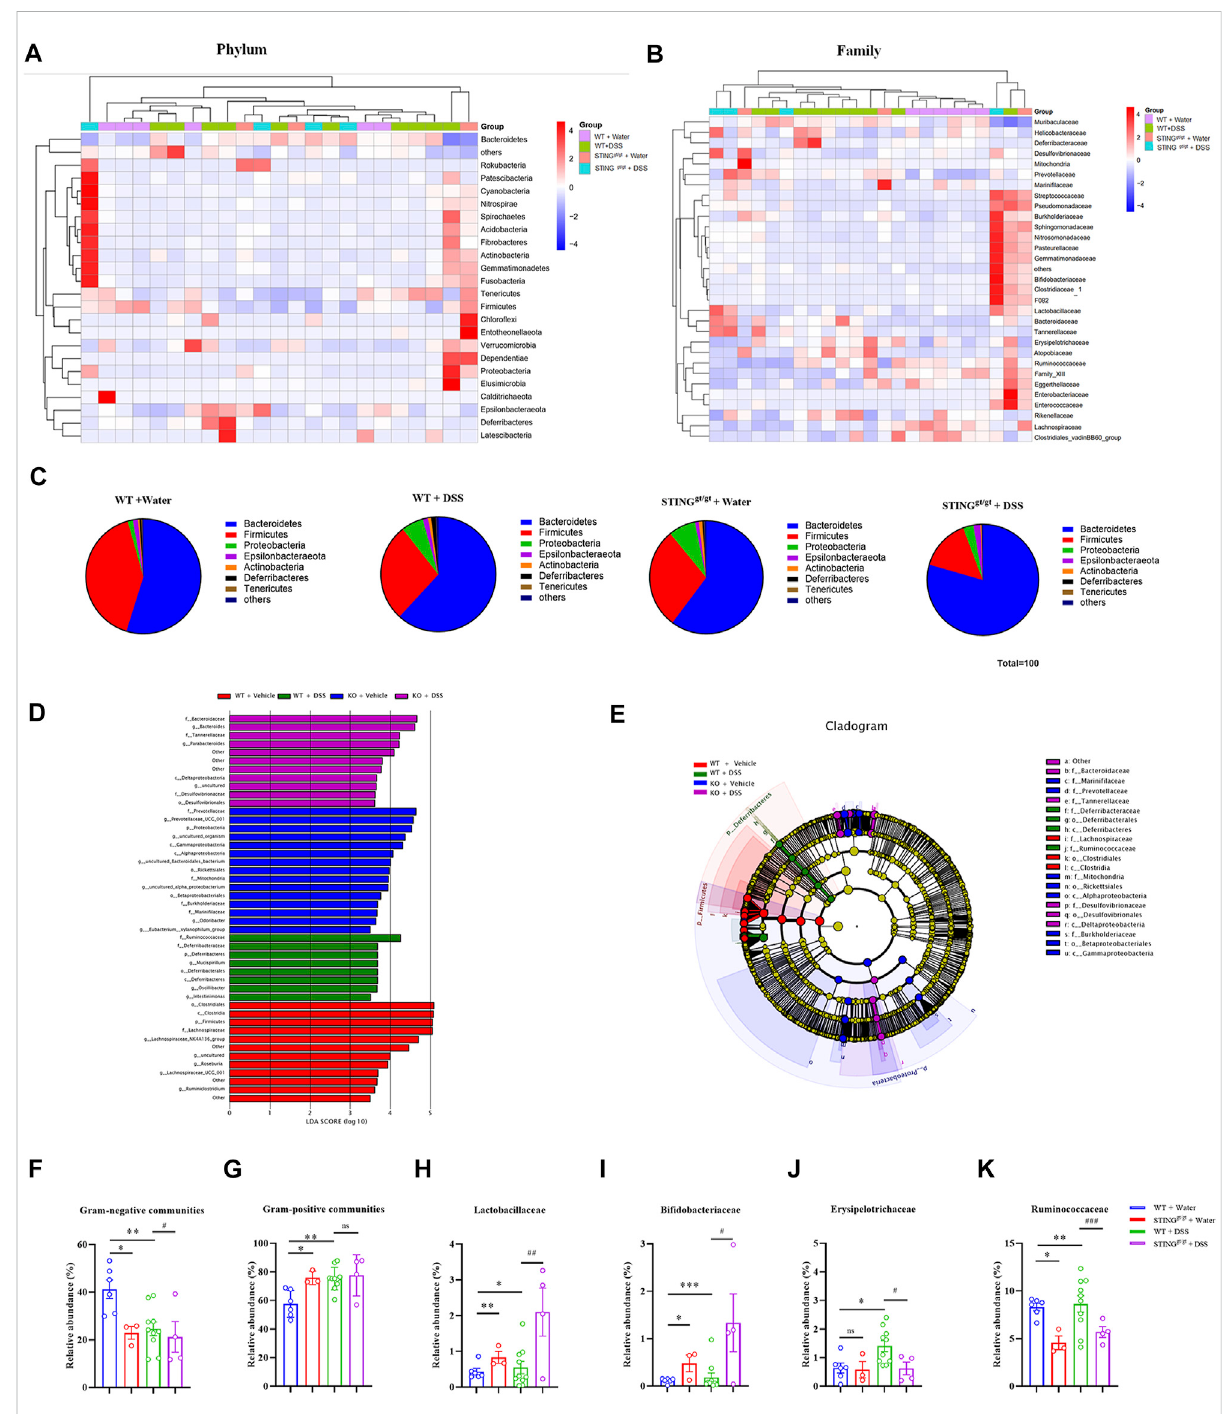
FIGURE 8 STING de fi ciency prevented dysbiosis induced by DSS-colitis in mice. (A) Heatmap analyses of differentially abundant phylum between the vehicle group, WT + DSS group, vehicle + STING gt/gt group, STING gt/gt + DSS groups. (B) Heatmap analyses of relative abundant bacterial family in eachfourgroup. (C) Relativeabundanceofthemainbacterialphylum indifferentgroup. (D) LEfSescore plotofthediscriminativemicrobialtaxathat are more enriched inthevehiclegroup (red), DSS(green),STING gt/gt (blue), and STING gt/gt + DSS(violet) groups. (E) Identi fi cationof differentially abundantmicrobialtaxausinglineardiscriminantanalysiseffectsize(LEfSe)analysis.LEfSecladogramofthediscriminativemicrobialtaxa;thesizeof thecircleshowedtherelativeabundanceofthetaxa,andthecolourshowsthedifferentgroup(red,vehiclegroup;green,DSSgroup;blue,STING gt/gt group; violet, STING gt/gt + DSS group). (F,G) Quanti fi cation of the relative abundance of Gram-negative communities (F) and Gram-positive communities (G) from (A) . (H – K) Quanti fi cation of the relative abundance of Lactobacillales (H) , Bi fi dobacteriales (I) , Bacteroidaceae (J) , Ruminococcaceae (K) from (B) .( n =3 – 10eachgroup,n.s.,nosigni fi cance,* p < 0.05,** p < 0.01,*** p < 0.001,unpairedStudent ’ s t -test).Alldatawas expressed as Mean ± SEM. WT, wild type. DSS, dextran sulfate sodium; WT, wild